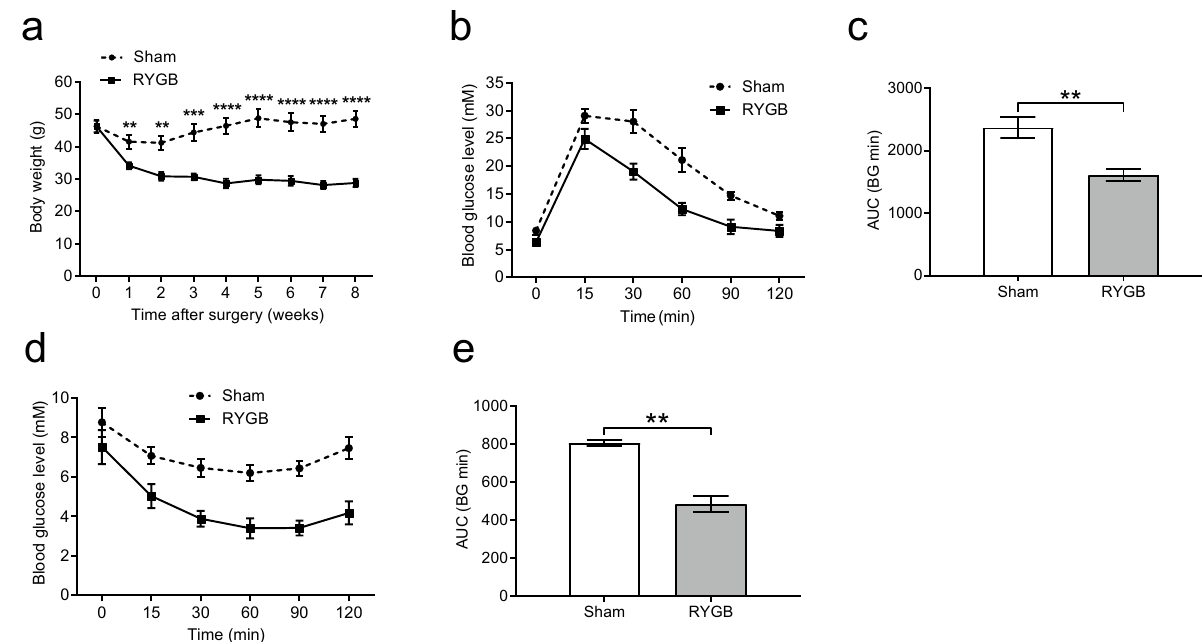
Figure 1. RYGB reduced body weight and improved glucose homeostasis. ( a ) The body weight of mice in the RYGB group ( n = 5/group) was significantly lower from postoperative week 1 to week 8 than that of mice in the sham group ( n = 6/group). ( b , c ) IPGTT measurement and AUC showed that in contrast to sham surgery, RYGB significantly reduced glucose levels and improved glucose tolerance. ( d , e ) The ITT test and AUC revealed that glucose levels were significantly lower in the RYGB group than in the sham group after insulin injection, reflecting enhanced insulin sensitivity. All data are the mean ± SEM. * p < 0.05; ** p < 0.01; *** p < 0.005; **** p < 0.001. AUC area under